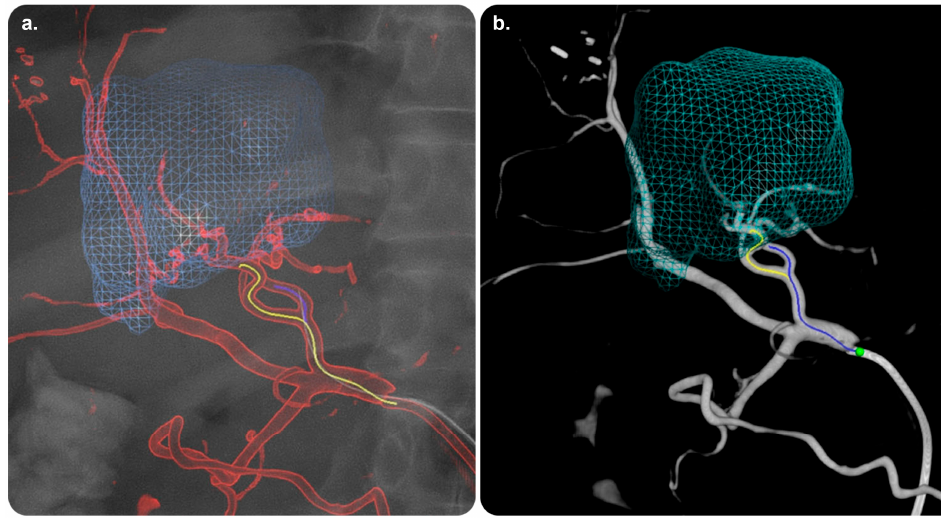
Figure 7. EmboGuide software and its role in the delivery of targeted therapy. ( a ) Feeding arteries superimposed on a live fluoroscopic image during selective catheterization. ( b ) 3D dynamic roadmap displayed on fluoroscopy after dual-phase CBCT enabling target volume segmentation, automatic feeding vessel detection, and selective microcatheterization of feeding vessels. Reprinted from “First human experience with directly image-able iodinated embolization microbeads” by Levy et al. [39] with written approval from the corresponding author and publisher (CardioVascular and Interventional Radiology; Copyright 2016).